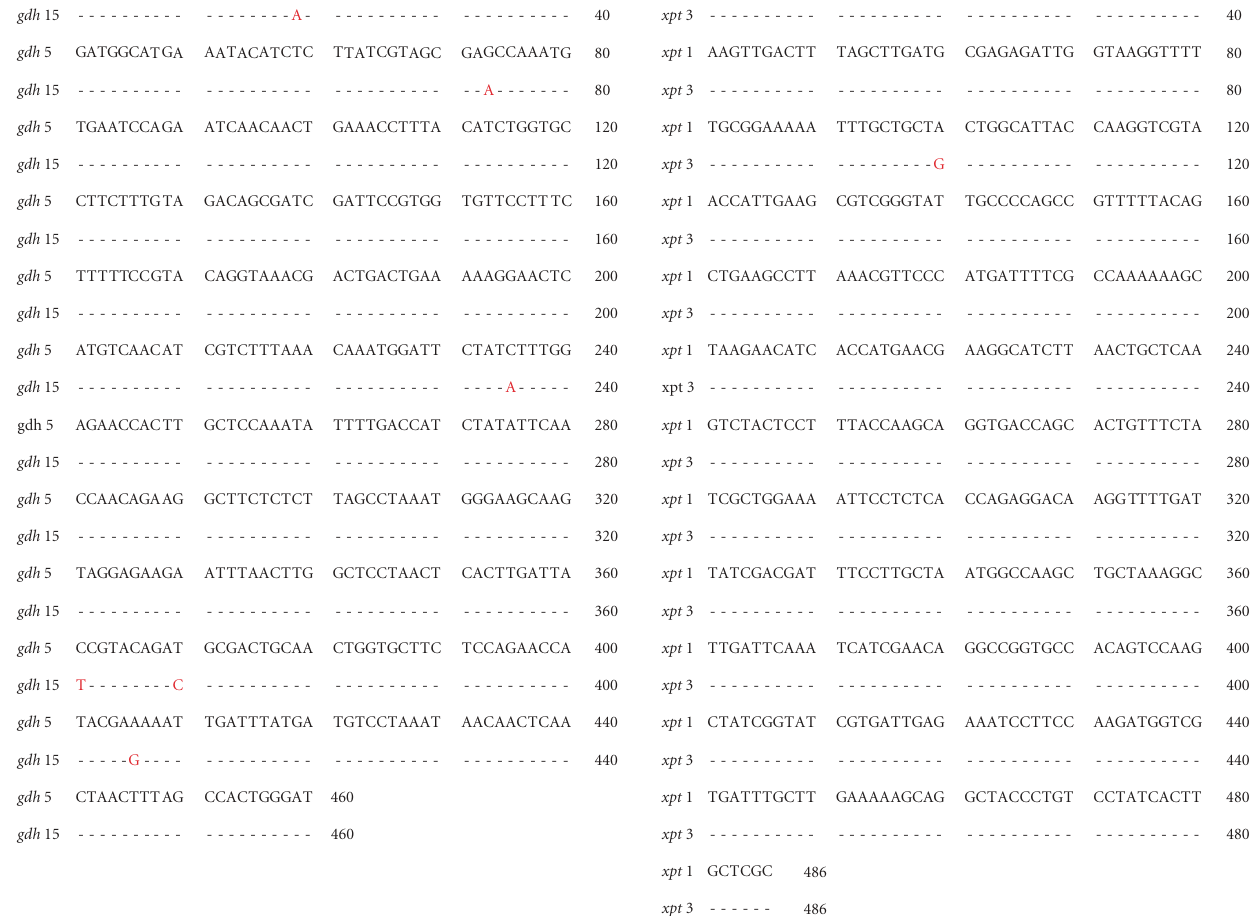
Figure 1: Alignment of sequences for alleles xpt and gdh for ST1989 and ST180 demonstrating one SNP di ff erence in the xpt gene at position 100 and six SNP di ff erences in the gdh gene at positions 19, 73, 235, 361, 370, and 406.